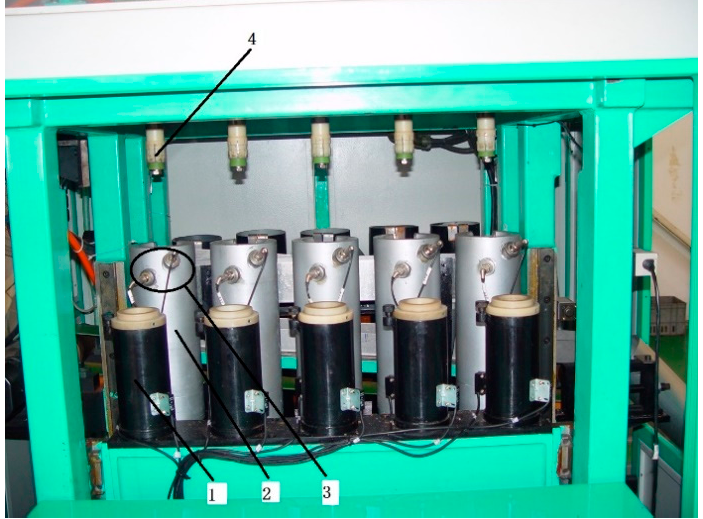
Figure 6. Core components of testing equipment (1. material-preparation container; 2. testing container; 3. ultrasonic transducer; 4. built-in